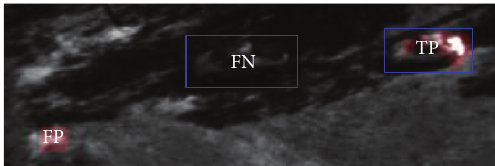
Figure 12: Evaluation of performance metrics TP, FP, and FN based on ground truth boxes (blue) and the detected region